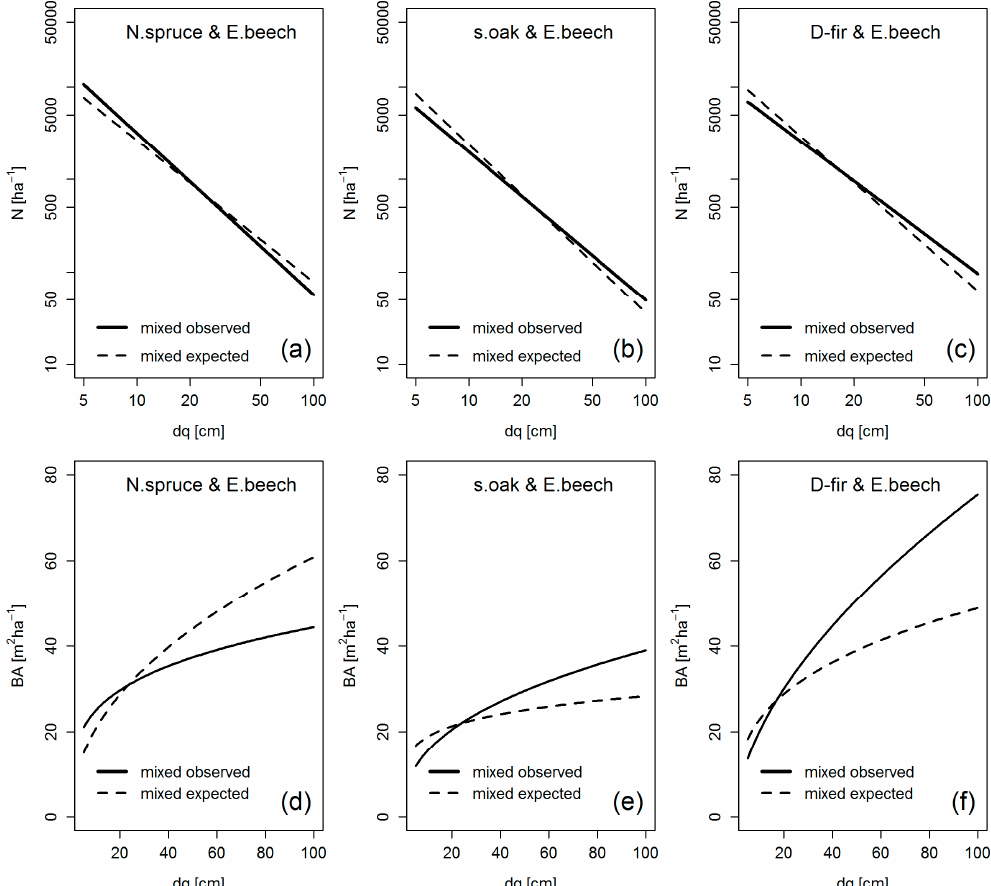
Figure 17. Observed (solid lines) versus expected (broken lines) development of the tree number and stand basal area development plotted over quadratic mean tree diameter. ( a – c ) N-dq relationships for mixed-species stands of Norway spruce and European beech, s.oak and European beech, and Douglas-fir and European beech. ( d – f ) BA-dq relationships for the respective tree species combinations. The raise of maximum stand density by mixing tree species increases from left to right.